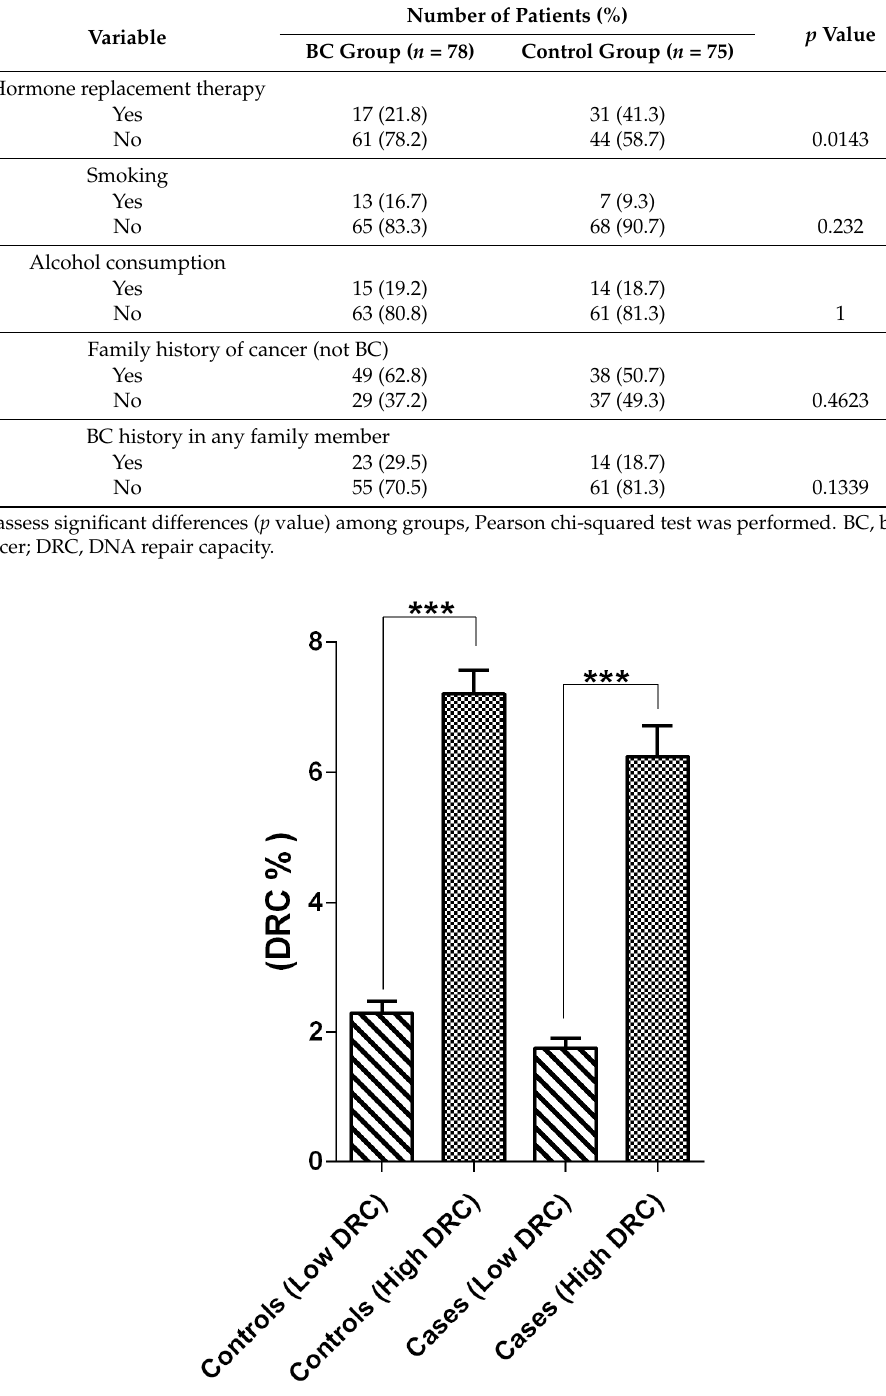
Figure 1. Sample stratification of 153 breast cancer patients and controls based on their DNA repair capacity (DRC) levels. These women were divided into four groups according to their DRC level: high (>3.8%) and low (<3.8%). The four groups consisted of BC patients with high ( n = 35) and low ( n = 43) DRC and controls with high ( n = 39) and low ( n = 36) DRC. Asterisk over the bars represent the statistical significance of the KW test, *** p < 0.001.